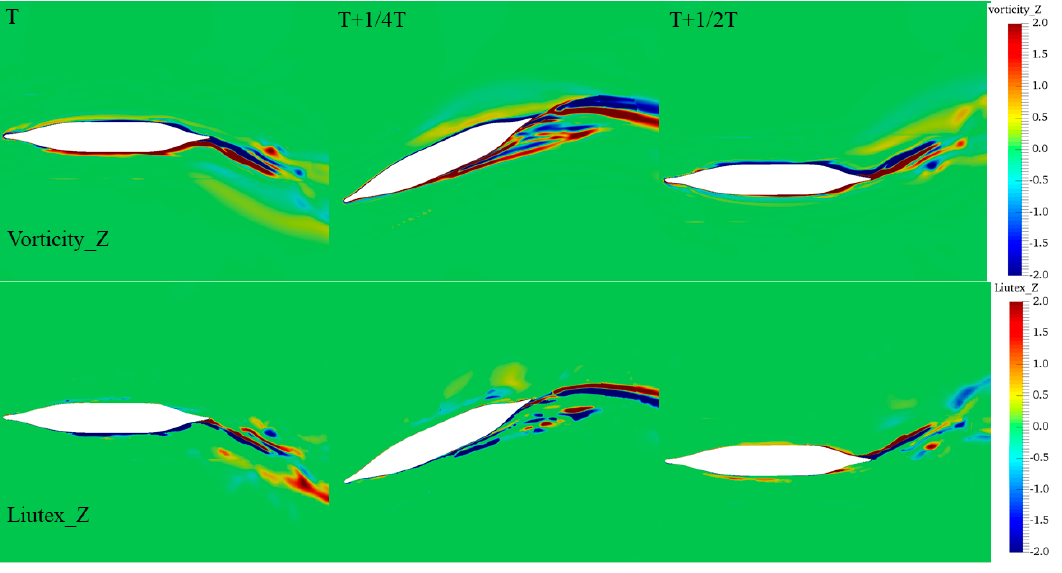
Figure 19. Vertical vorticity (top) and Liutex (bottom) at z / L pp = − 0.03572 in CASE PY8.